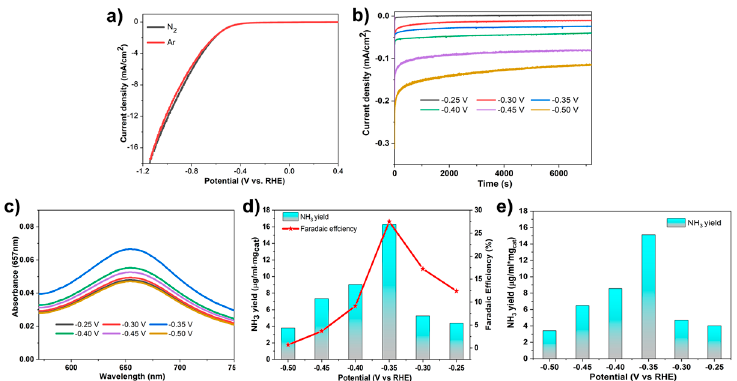
Figure 1. ( a ) Linear sweep voltammetry (LSV) curves for the catalyst NC-800 in Ar- and N 2 -saturated 0.1 M HCl. ( b ) Time-dependent current density curves of NC at a suit of potentials for 2 h in N 2 -saturated 0.1 M HCl. ( c ) UV-Vis absorption spectra of the electrolyte colored with indophenol indicator for 2 h. ( d ) The obtained NH 3 yield rates and Faradaic efficiency (FEs) for NC-800 at different potentials. ( e ) The obtained NH 3 yield rates for NC under various potentials determined by ion chromatography.